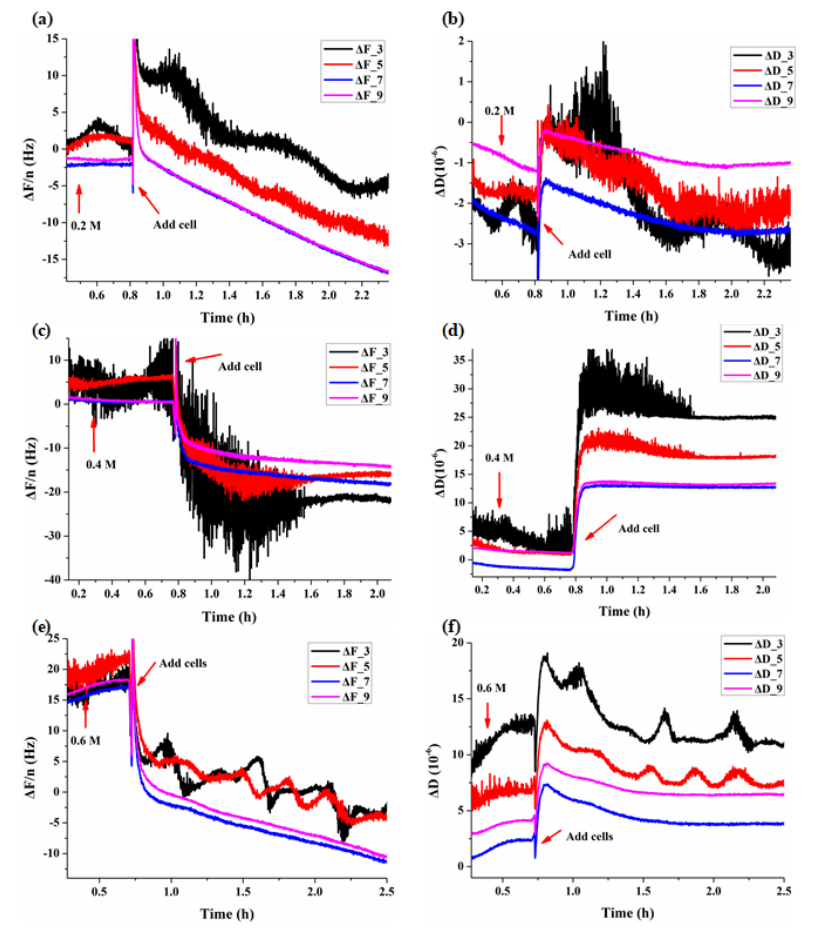
Figure 2. Dynamic QCM responses during the adhesions of BY-2 cells on (PDADMAC)/SiO 2 crystals in different mannitol concentrations. ( a , b ) 0.2 M, ( c , d ) 0.4 M, ( e , f ) 0.6 M.